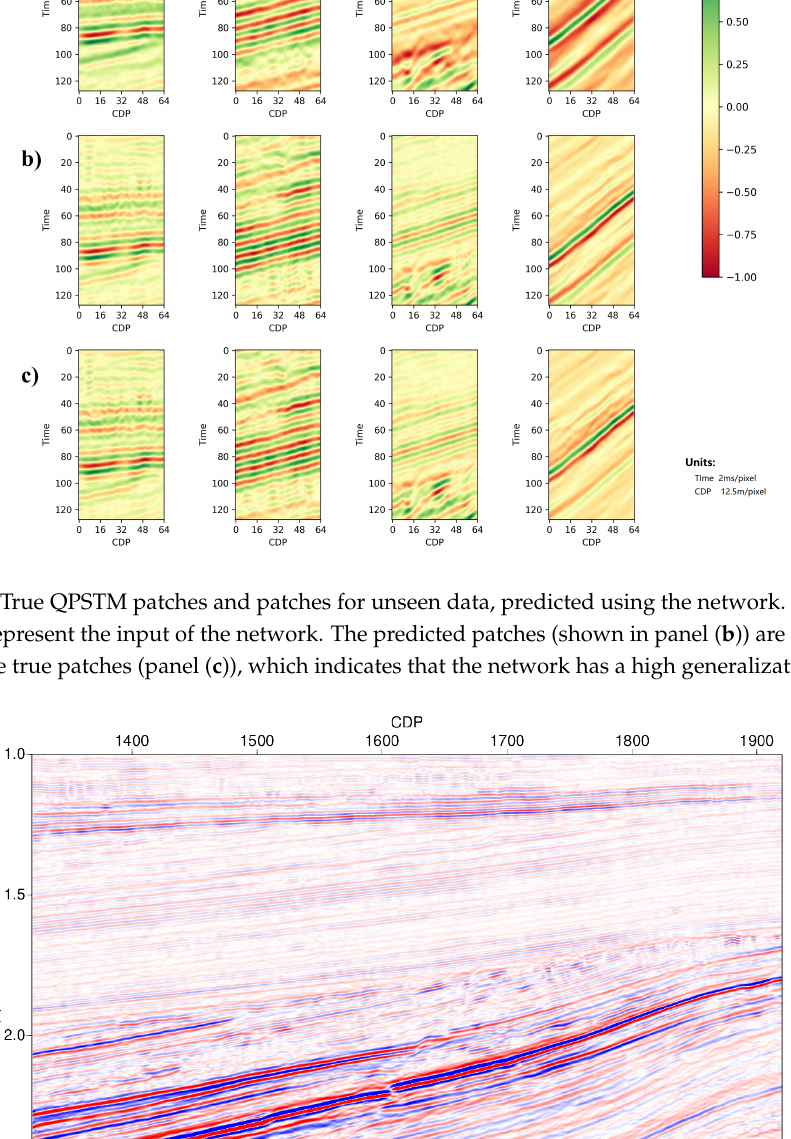
Figure 15. The frequency when using the learning method improved by approximately 16 Hz at the high-frequency end at − 20 dB, compared with that for the conventional PSTM result. Both the learned network and the QPSTM exhibit a comparable performance in terms of the frequency improvement.